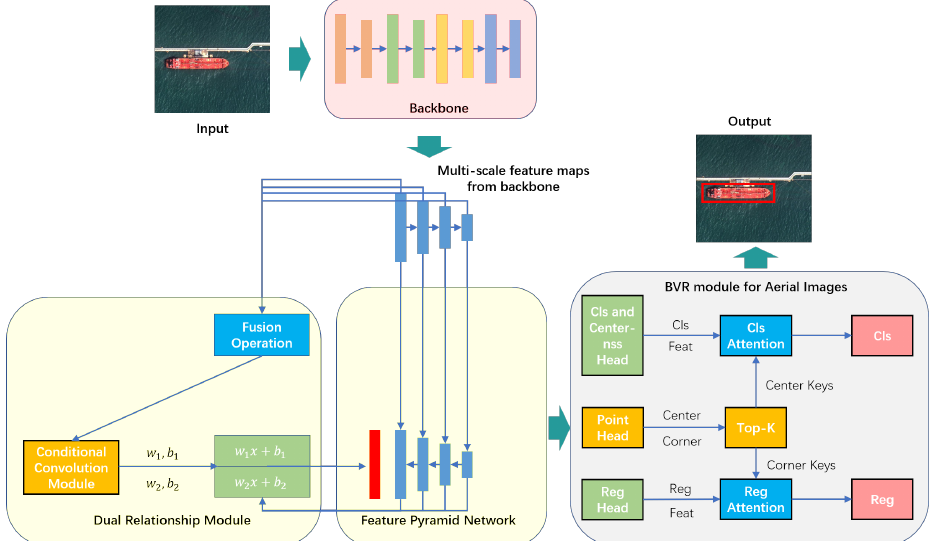
Figure 2. The proposed framework, namely, the relationship representation network for object detection in aerial images (RelationRS), is made up of three components: the baseline network, which is made up of the fully convolutional single-stage detector with no anchor setting (FCOS) [22] and the feature pyramid network (FPN) [12]; the dual relationship module, which learns the potential relationship between different scales of the objects and the potential relationship between different scenes of aerial images in one batch; and the bridging visual representation module for aerial image object detection task, which learns the potential relationship between different coordinate representations based on BVR module [31].